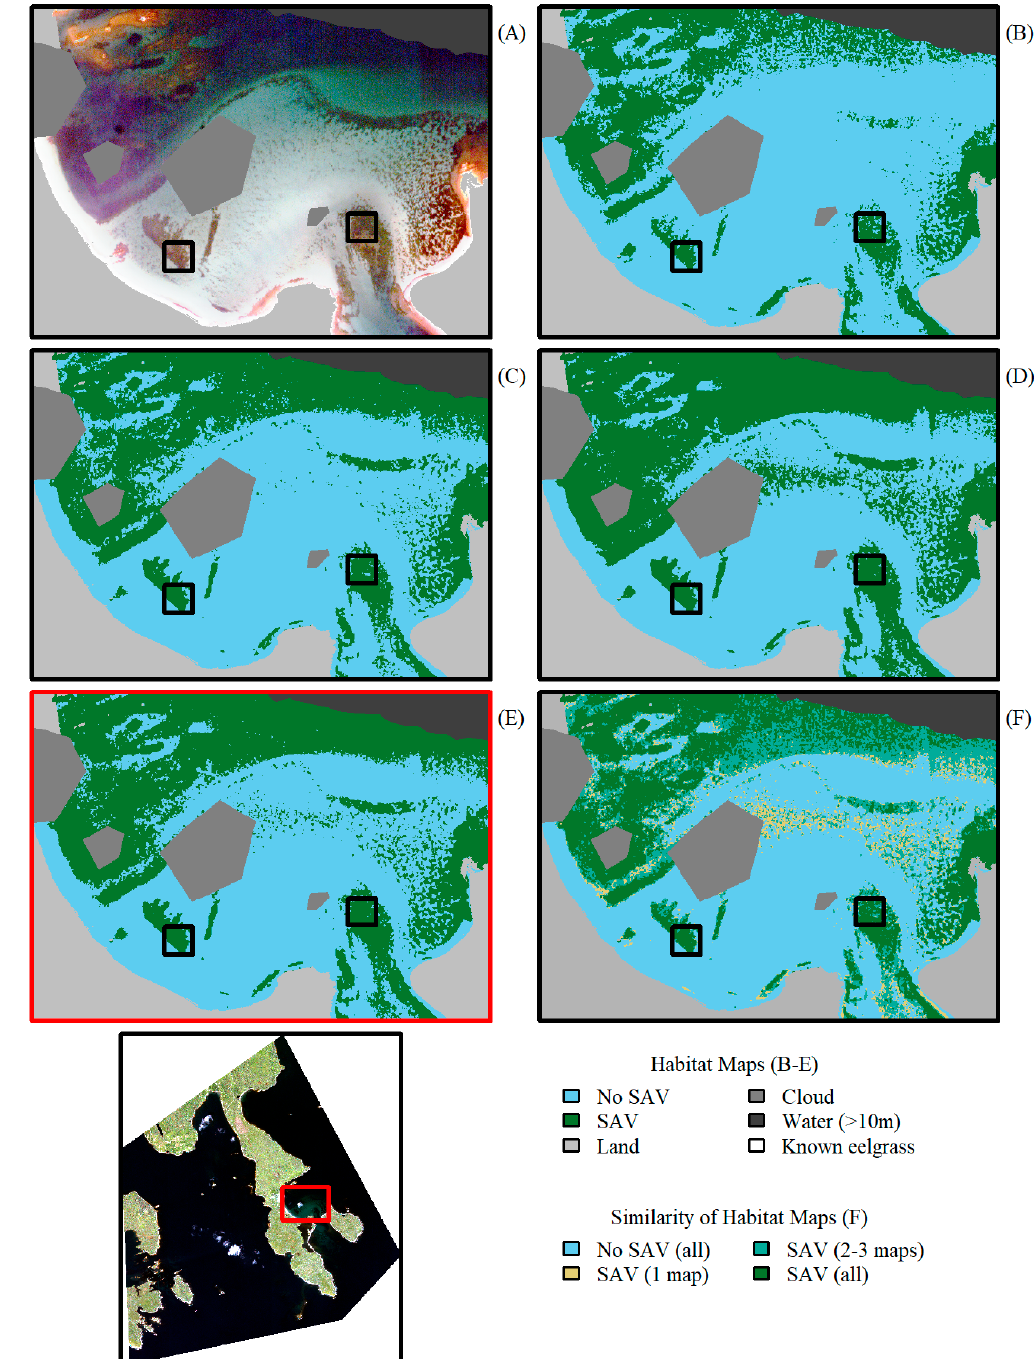
Figure 6. Representative bottom habitat classification with various input combinations for the 17 August WorldView-3 image indicating vegetation presence (SAV) and absence (No SAV), image- based land mask (grey), and the true colour composite ( A ). Bottom habitat classification on only the depth invariant indices ( B ), on the first four principal components ( C ), the six spectral bands ( D ), and the six spectral bands with the four principal components, and the depth invariants indices ( E ). Comparison of the similarity between habitat maps where all habitat maps indicate vegetation absence (light blue), all indicate presence (dark green), and where the maps disagree (yellow: 1–2 maps show presence; light green: 3–4 maps show presence) ( F ). Known locations of vegetated habitat (specifically eelgrass) are indicated by the black boxes. Red outline ( E ) denotes the top performing classification.